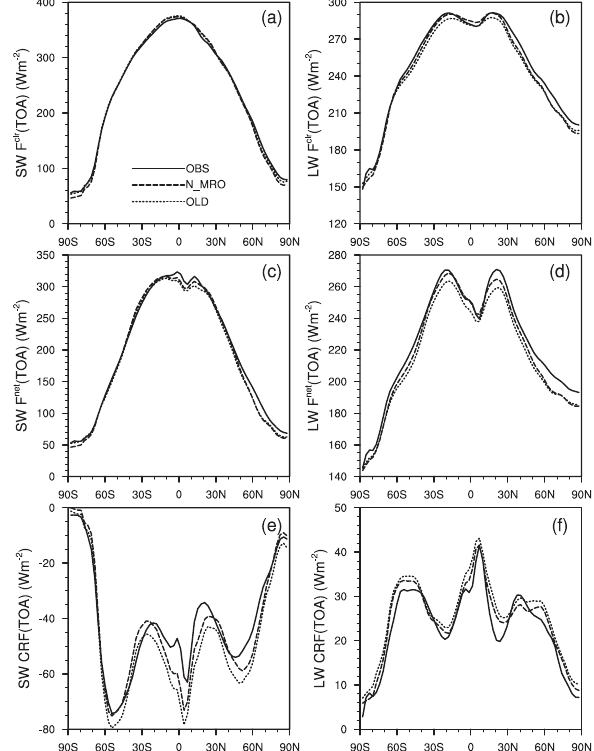
Fig. 2. F clr (top), F net (central), and CRFs (bottom) at the TOA for LW (left) and SW (right) from OLD, N_MRO, and CERES_EBAF